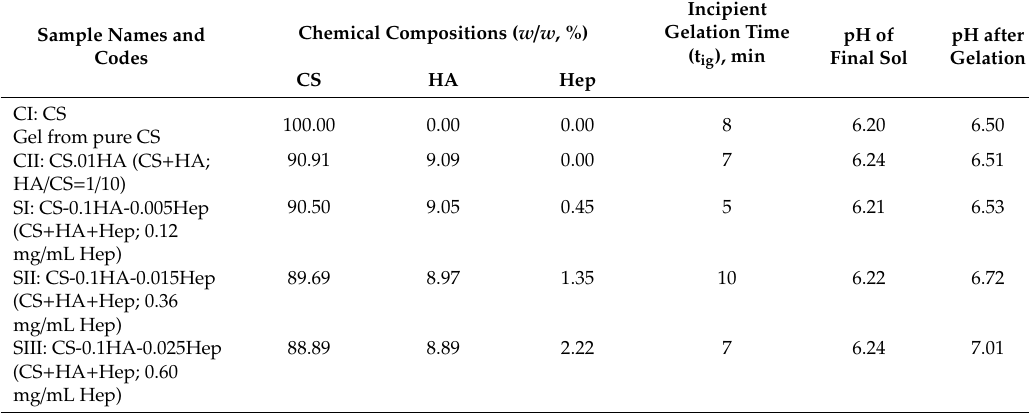
Table 1. Di ff erent hydrogel compositions according to their weight ratio, pH values of solutions and hydrogels and incipient gelation time in test tubes at 37 ◦ C.